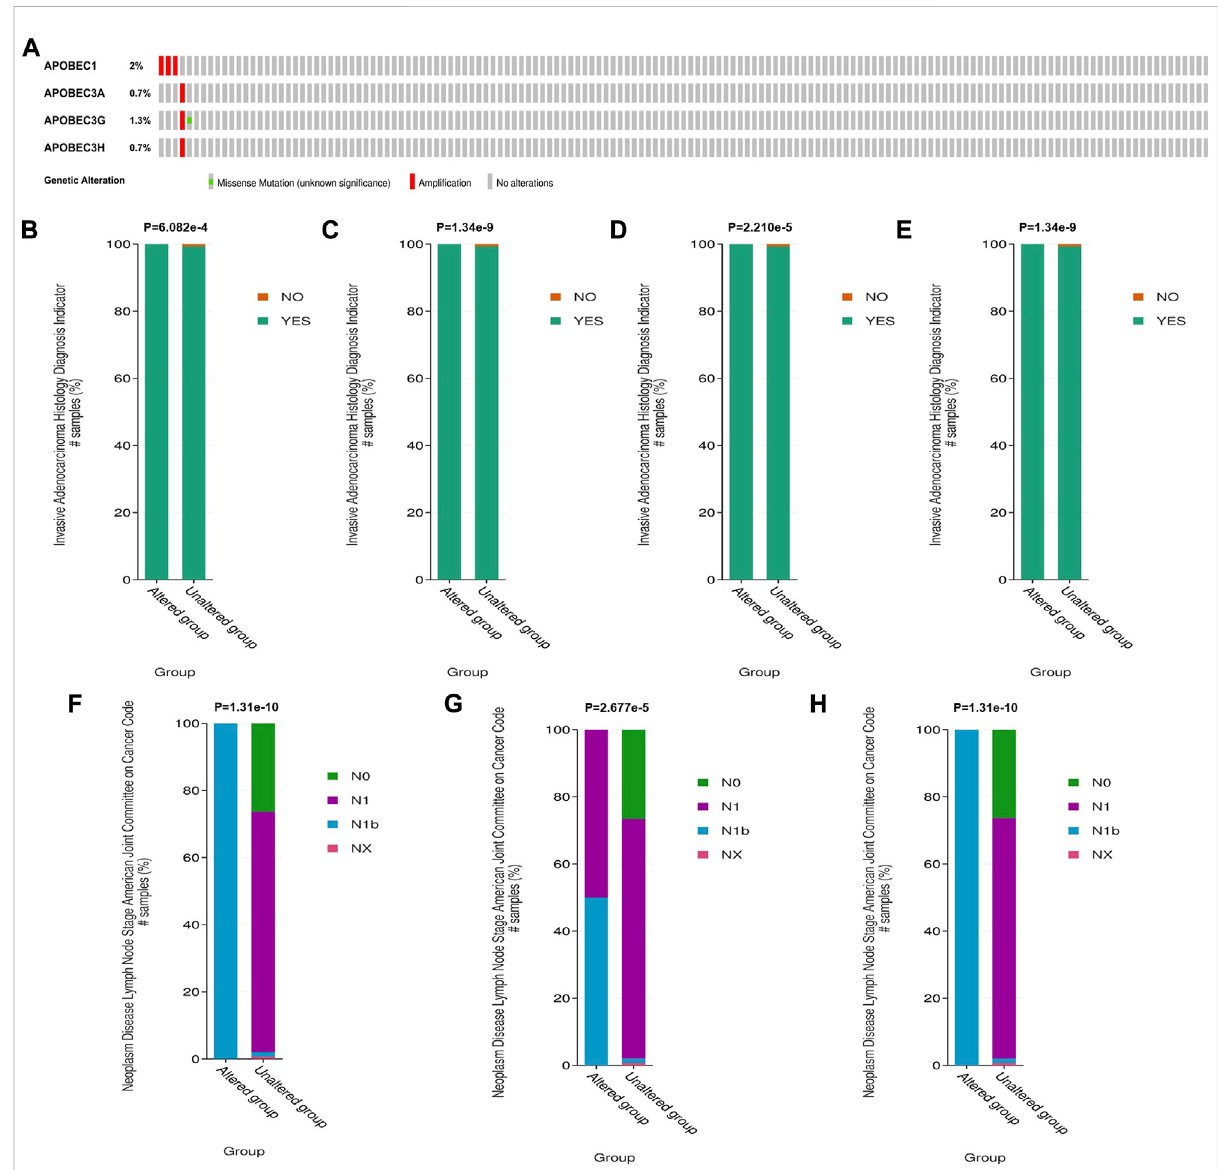
FIGURE 3 Genetic variation analysis of the APOBEC family members APOBEC1, APOBEC3A, APOBEC3G and APOBEC3H in PAAD. (A) Gene variation characteristicsoftheAPOBEC1/3A/3G/3HinPAAD; (B – E) Theampli fi cationvariantsofAPOBEC1/3A/3G/3Hweresigni fi cantlycorrelatedwithPAAD invasion of surrounding tissues; (F – H) The ampli fi cation variants of APOBEC3A/3G/3H were signi fi cantly correlated with Higher N stage of